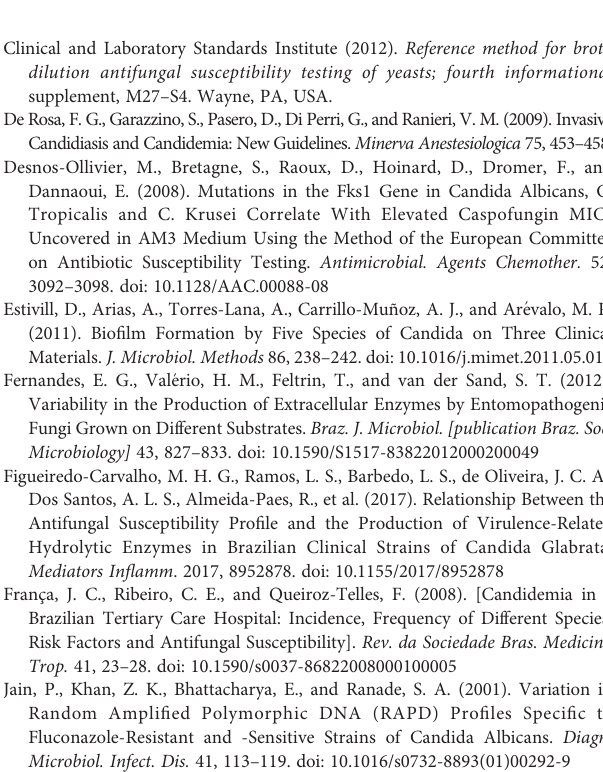
Supplementary Figure 1 | Comparison of the virulence levels (bio fi lm biomass, casein activity, and hemolysin activity) of three Candida species isolates by genotypic relatedness. Y-axis (far left panel): bio fi lm biomass (positively correlated with virulence); Y-axis (far right panel): the Pz values of caseinase and hemolysin activities (negatively correlated with virulence). No signi fi cant differences can be notedinthis fi gure. (A) Thevirulencelevelof40C . albicans isolatesfromdifferentgene clusters; (B) The virulence level of 37 C . parapsilosis isolates from different gene clusters; (C) The virulence level of 21 C . tropicalis isolates from different gene